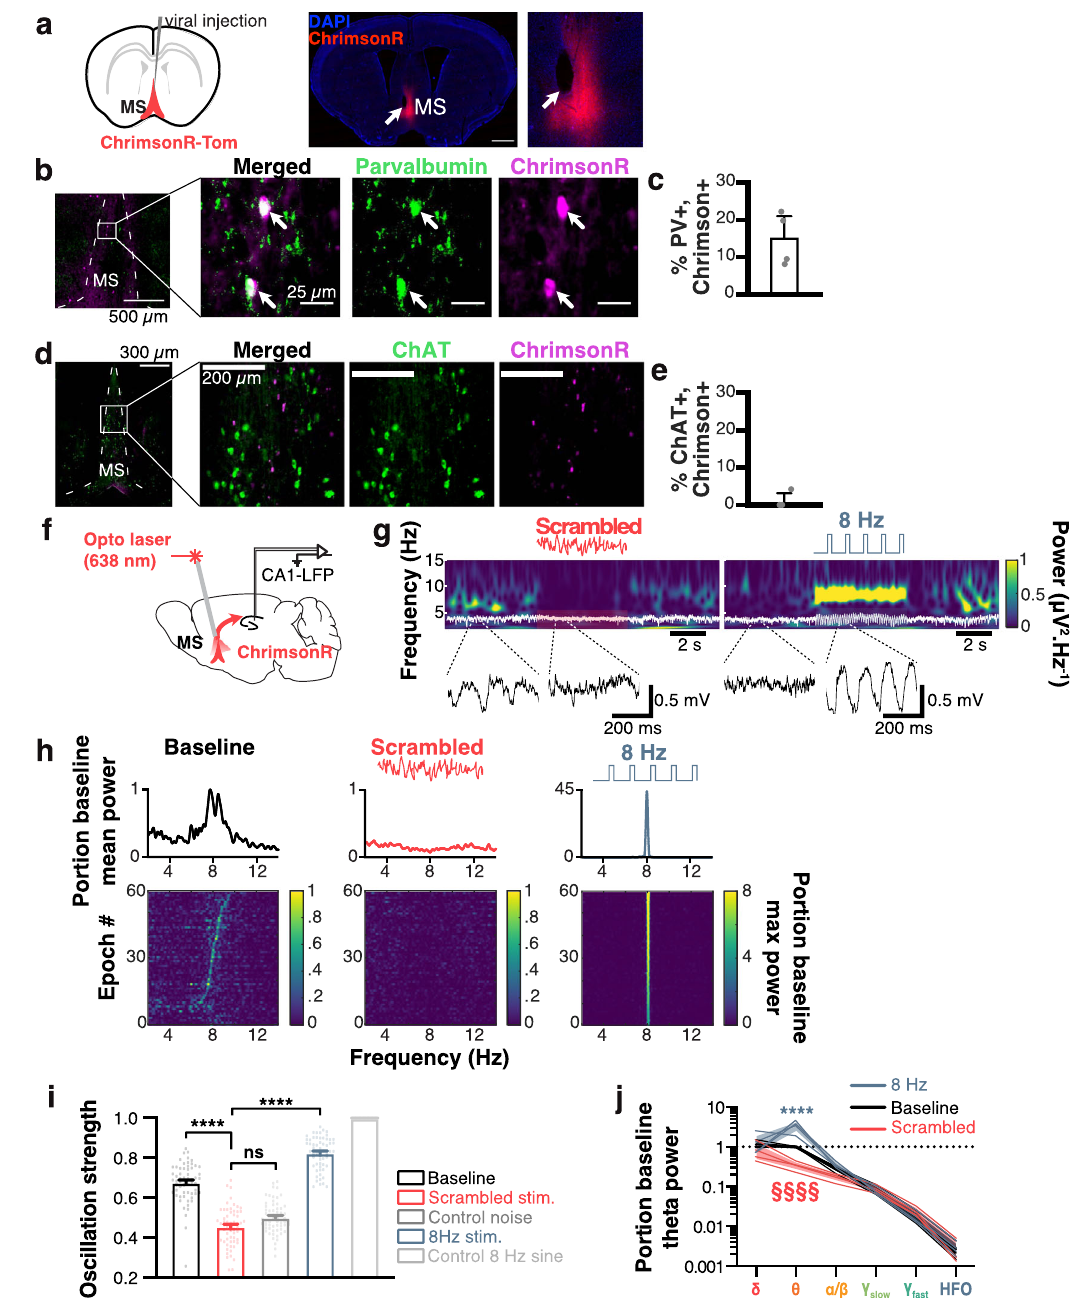
Fig. 2 | Selective optogenetic pacing and ablation of theta oscillations. a AAV- ChrimsonRexpressingvectorwasinjectedintheMS(blue,DAPI;red,ChrimsonR), anda fi beropticwasplacedattheinjectionsite(whitearrow).Scalebar,1mm(MS, medial septum). b Immunohistological double staining for ChrimsonR (magenta) and parvalbumin (PV; green) neurons. c Quanti fi cation of ChrimsonR+/PV+ co- expressing neurons ( N =4 mice). d Immunohistological double staining for ChrimsonR(magenta)andcholinergic(ChAT+;green)neurons. e Quanti fi cationof ChrimsonR+/ChAT+ co-expressing neurons ( N =4 mice). f Recording con fi gura- tion, with fi ber optic in the MS and electrode in CA1. g Wavelet spectrograms before, during, and after scrambled (left, in red) and 8Hz (right, in blue) stimula- tion patterns, with associated un fi ltered LFP (white overlay, and enlarged, black traces at the bottom; dark blue, low power; bright yellow, high power). h Average Fourier power spectra for 60×5s stimulation epochs (top), and sorted power